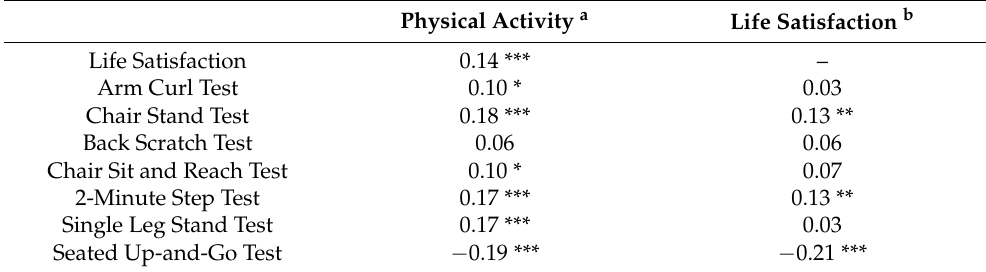
Table 2. The correlations between physical activity and life satisfaction and functional